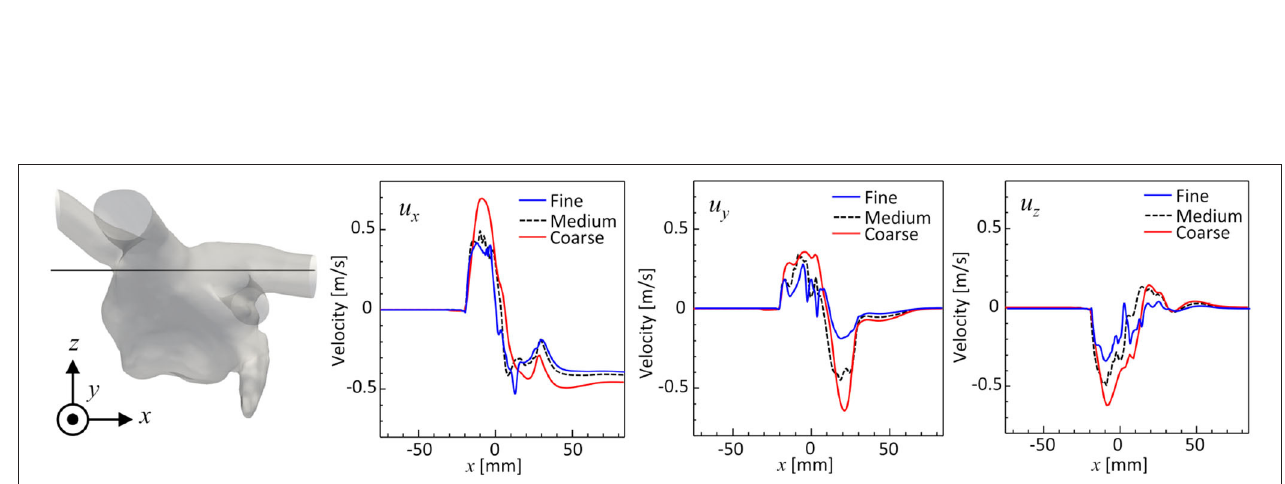
FIGURE A2 | Velocity profiles on the line probe along the x-direction in the upper region of the left atrium at t = 0.2 T for fine (512 × 512 × 512, grid size = 0.3 mm), medium-resolution (256 × 256 × 256, grid size = 0.6 mm), and coarse (128 × 128 × 128, grid size = 0.9 mm) grids.